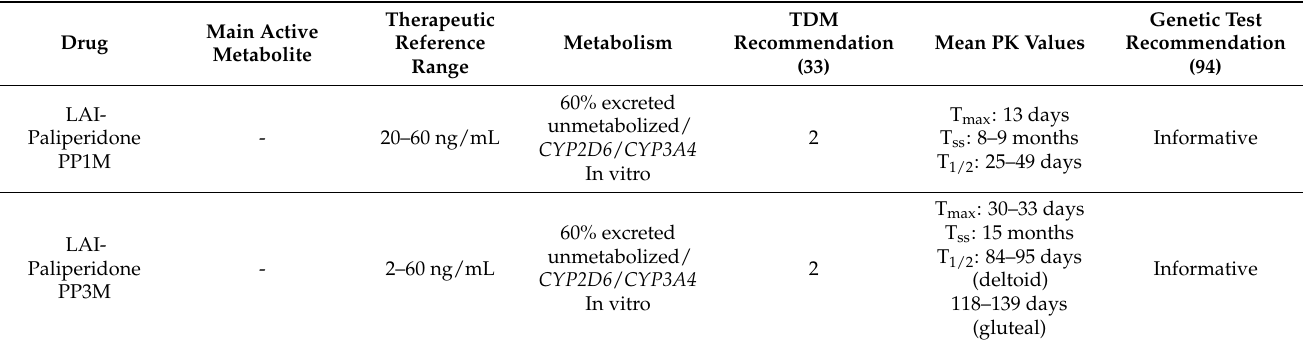
Table 4. Summary of PK/PG characteristics of LAI-Paliperidone.